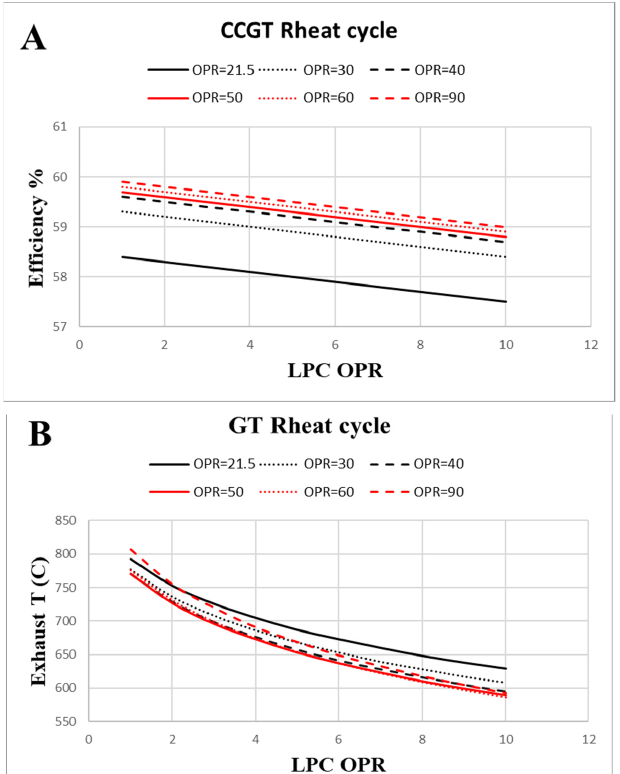
Figure 8 . ( A ) Effects of the compression ratio with changing LPCs in the reheat CCGT cycle. ( B ) Effects of the compression ratio with changing LPCs in the reheat GT cycle.